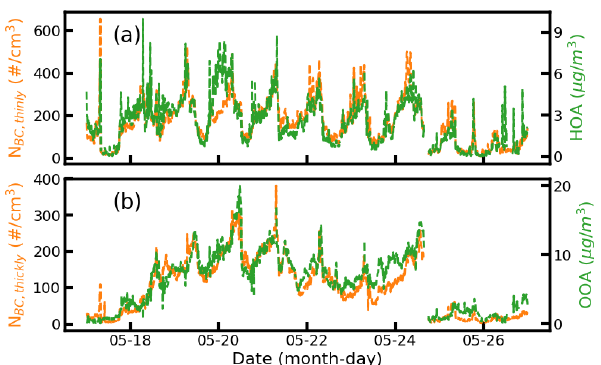
Figure 4. The time series of (a) the number concentration of the thinly coated BC (orange) and the mass concentration of HOA (green), (b) the number concentration of thickly coated BC (or- ange), and the mass concentration of OOA (green) for the CP